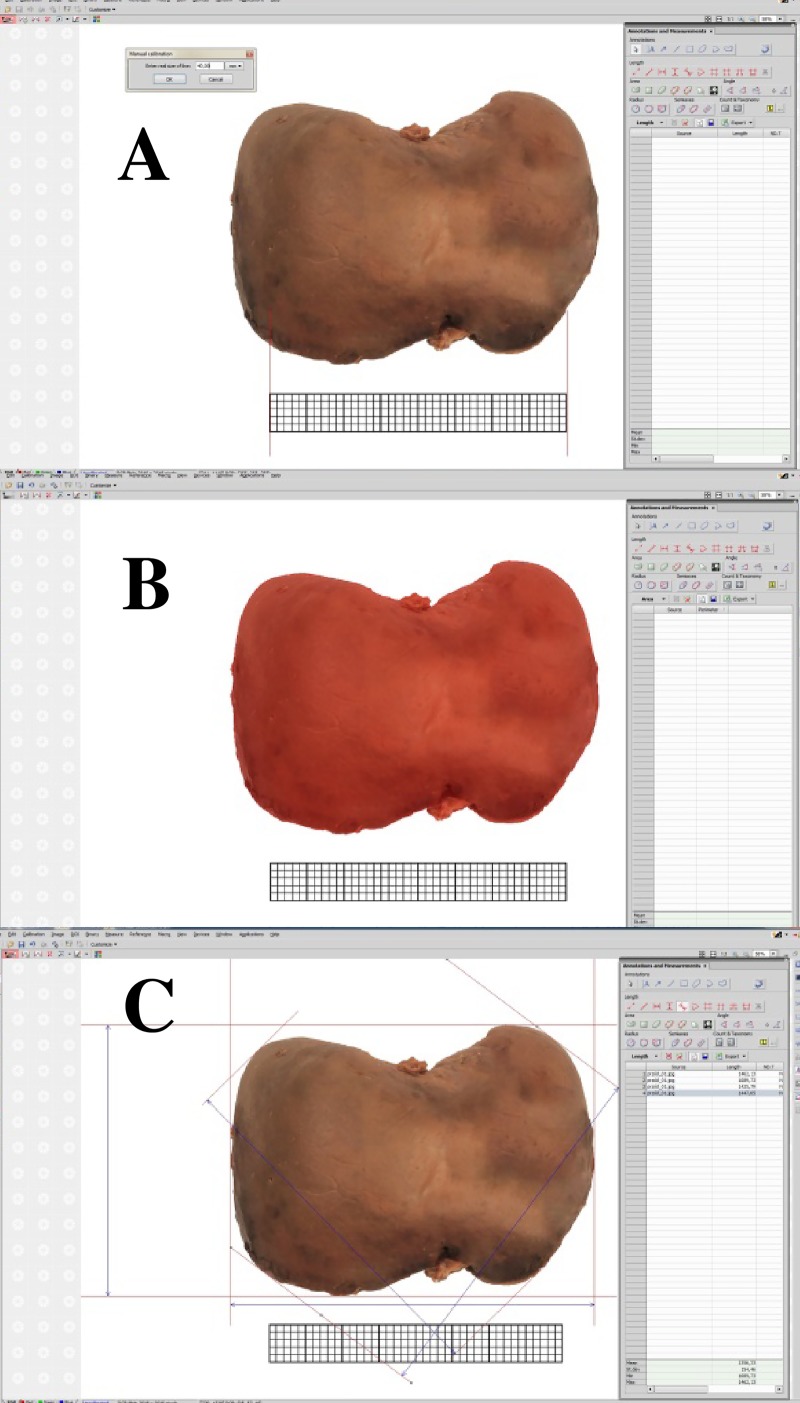
A screen of digital image analysis of NIS Elements AR 3.0 (Nikon) during: (A) calibration procedure, (B) and (C) linear measurements of the liver in the anterior projection.